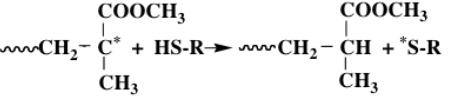
Figure 2. The reaction of a thiol with a poly(MMA) growing radical